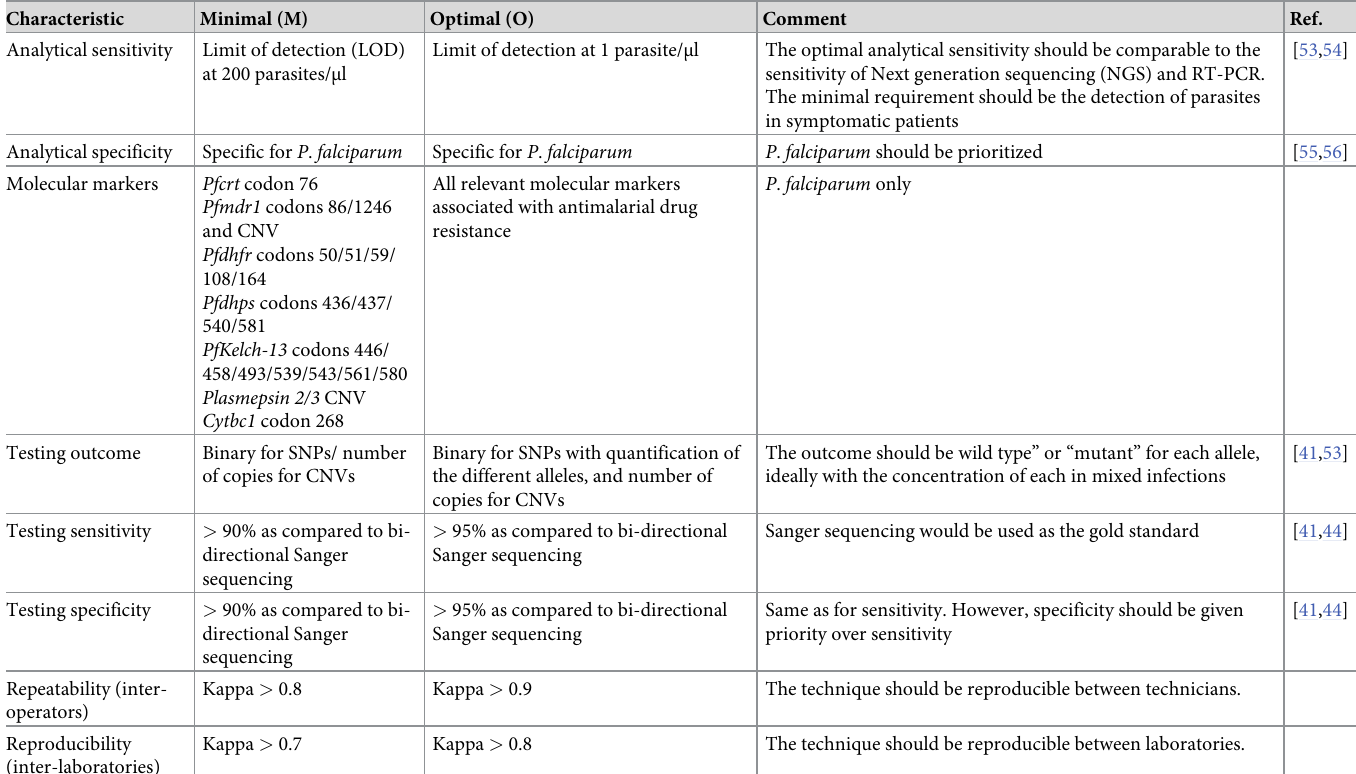
Table 3. Performance characteristics based on the consensus by the meeting of